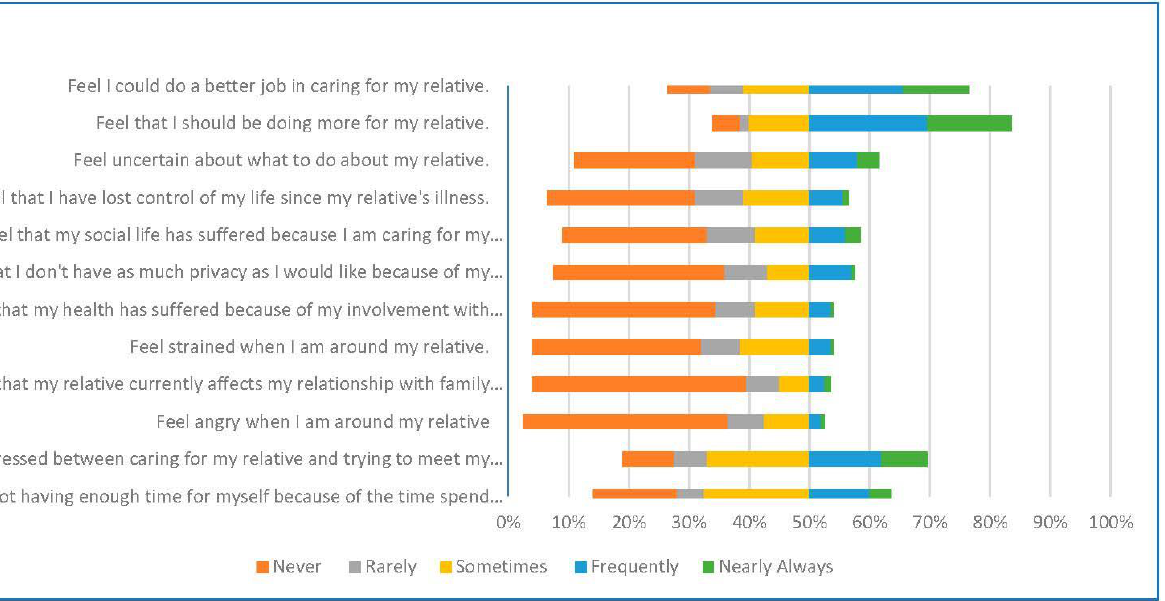
Figure 1. Caregiver Burden Assessment that Represents the Feelings of a Caregiver in Providing Care for Alzheimer’s Patients. for Alzheimer’s